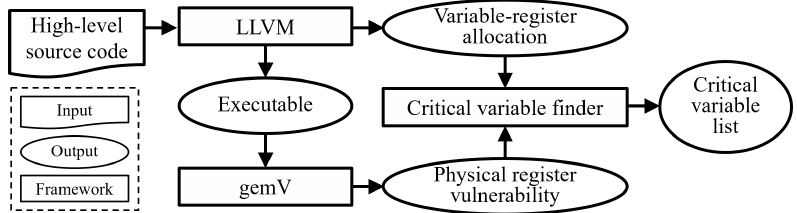
Figure 1. Overview of the high-level variable vulnerability estimation